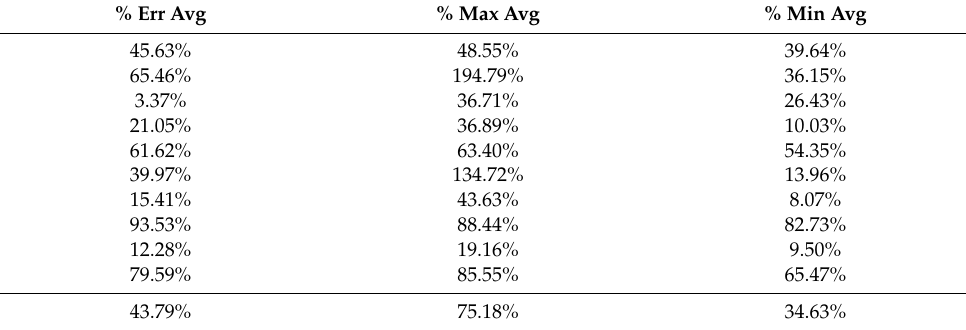
Table A43. Set 1, trials 21–30 data (average actual PR